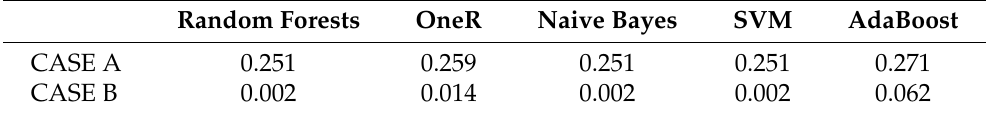
Table 4. False positive rate (%) for CASE A and B.